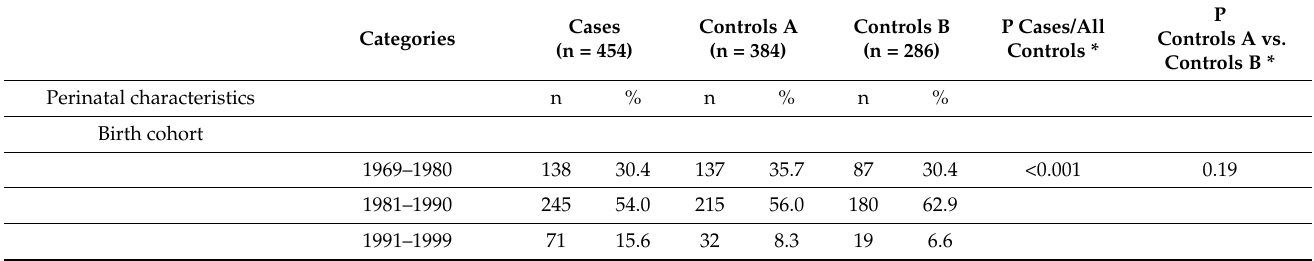
Table 1. Major characteristics of the study population, TESTIS study, 2015–2018, France, n = 1124. Cases Categories (n =